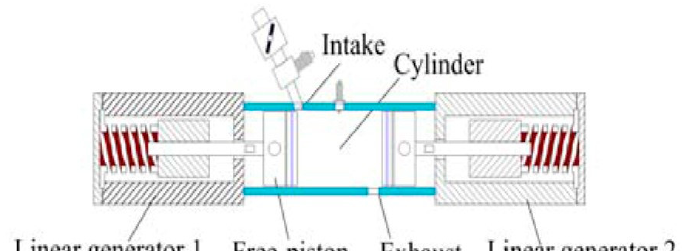
Figure 20. Opposed-piston free-piston linear.